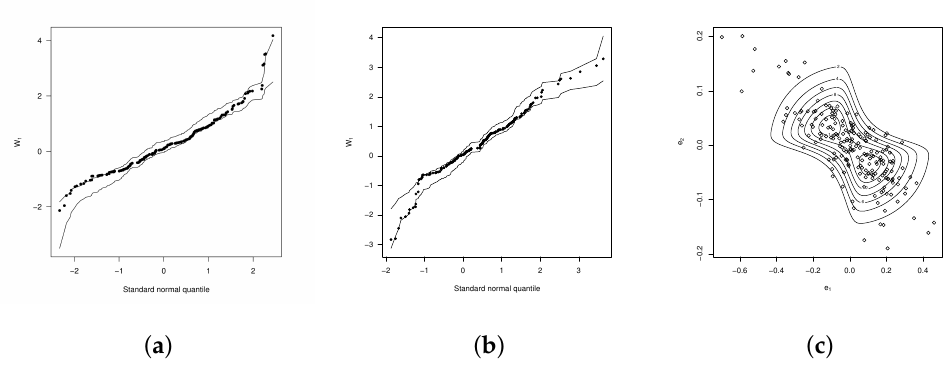
Figure 4. Envelope plots for the marginals and contour for the fitted model. ( a ) W 1 , ( b ) W 2 , and ( c )